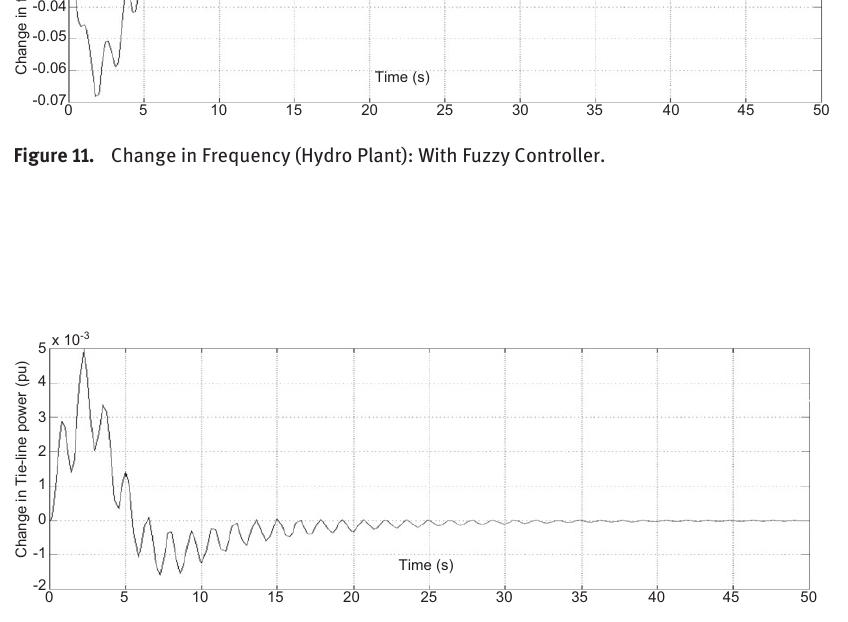
Figure 12. Change in Tie-Line Power (Thermal Plant): With Fuzzy